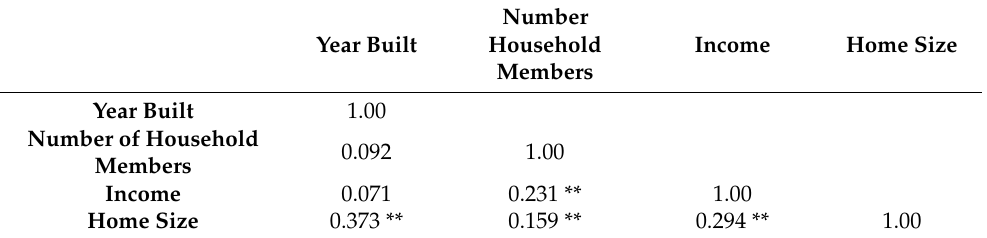
Table 5. Correlation analysis—Hot-Dry and Mixed-Dry Climate (Spearman’s ρ ).